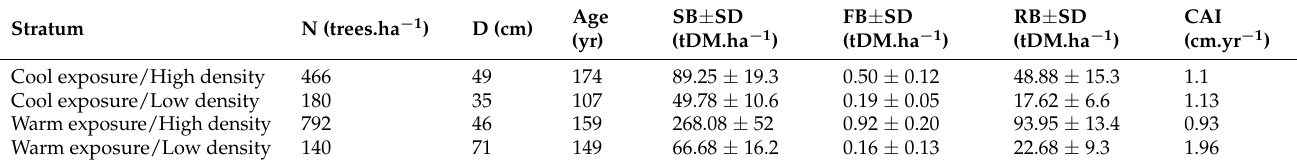
Table 5. Forest inventory results by sampling stratum.